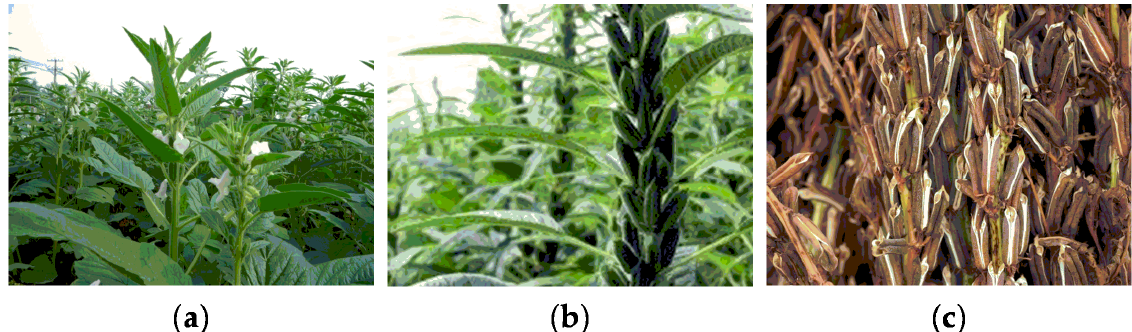
Figure 2. Different growth states of sesame. ( a ) Sesame blooming; ( b ) unripe sesame pods; ( c ) ripe sesame sesame pods.